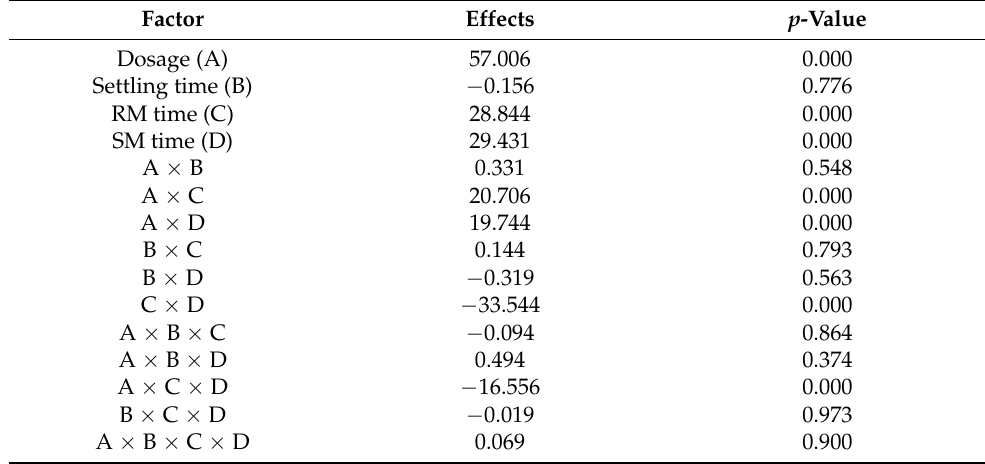
Table 5. Effects and factor interaction analysis for C. vulgaris flocculation with Zetag